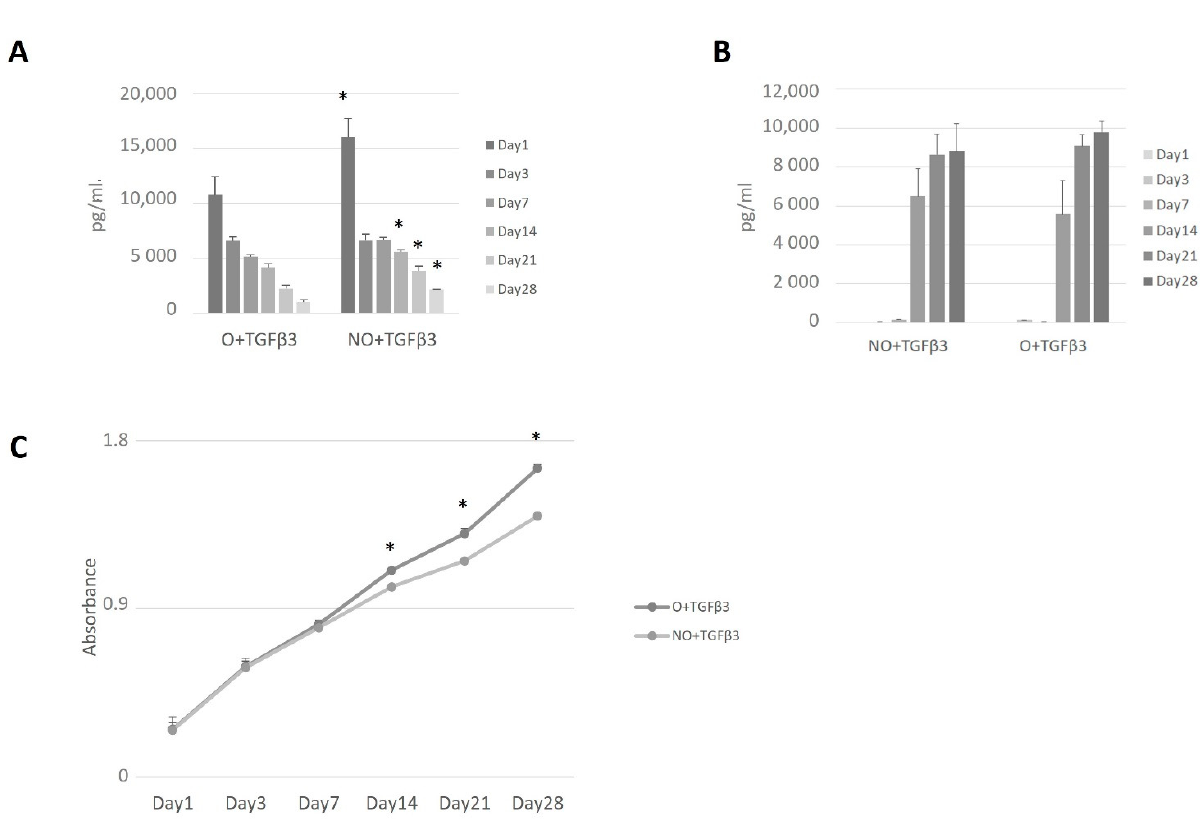
Figure 5. TGF- β 3 release from the scaffold with hMDSCs ( A ), collagen production from ozone-treated and untreated scaffolds ( B ), and cell proliferation within functionalized scaffolds ( C ). TGF- β 3 and collagen-II protein levels were tested at days 1, 3, 7, 14, 21, and 28 via ELISA. Cell proliferation rate was tested at the given timepoints via CCK-8. Results are presented as mean +/ − standard deviation. * represents p -value < 0.05 comparing NO + TGF- β 3 at all timepoints to ozonated scaffolds ( A , B ). NO—untreated, O—ozone-treated, TGF- β 3—transforming growth factor beta-3, pg/mL—picograms per milliliter.